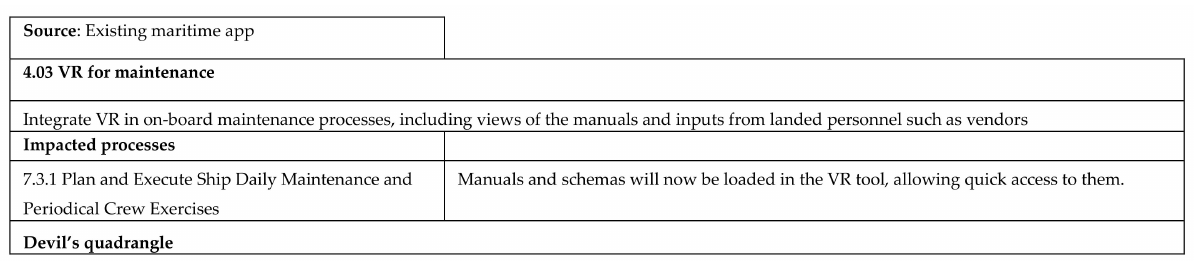
Figure A35. Cont